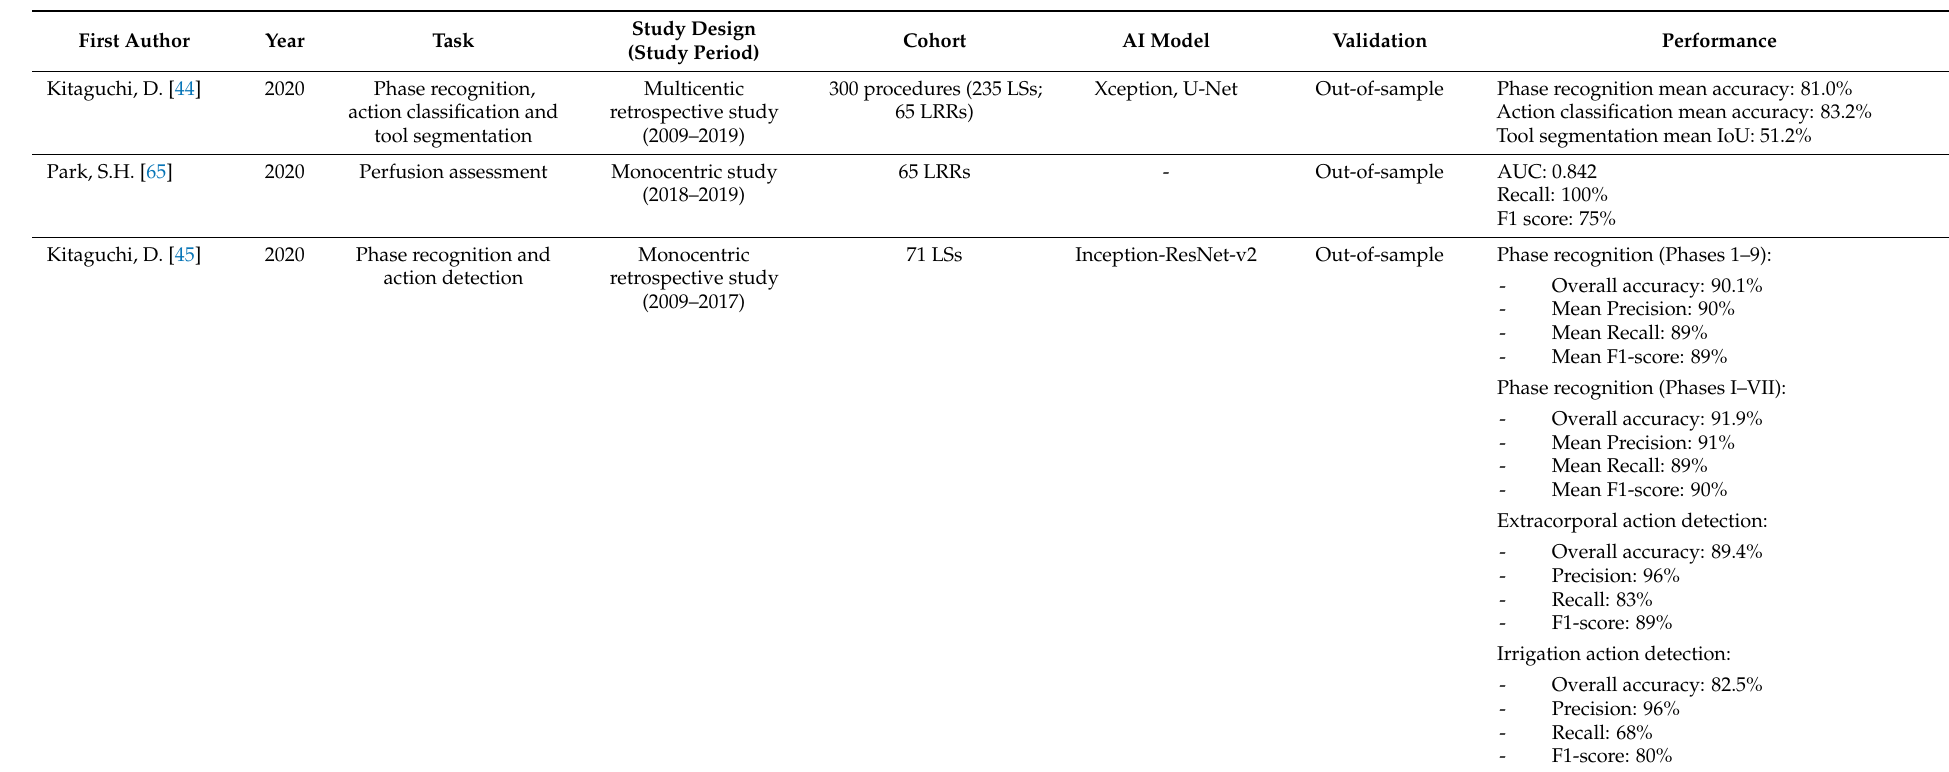
Table 2. Schematic summary of the reviewed studies using AI to analyze colorectal